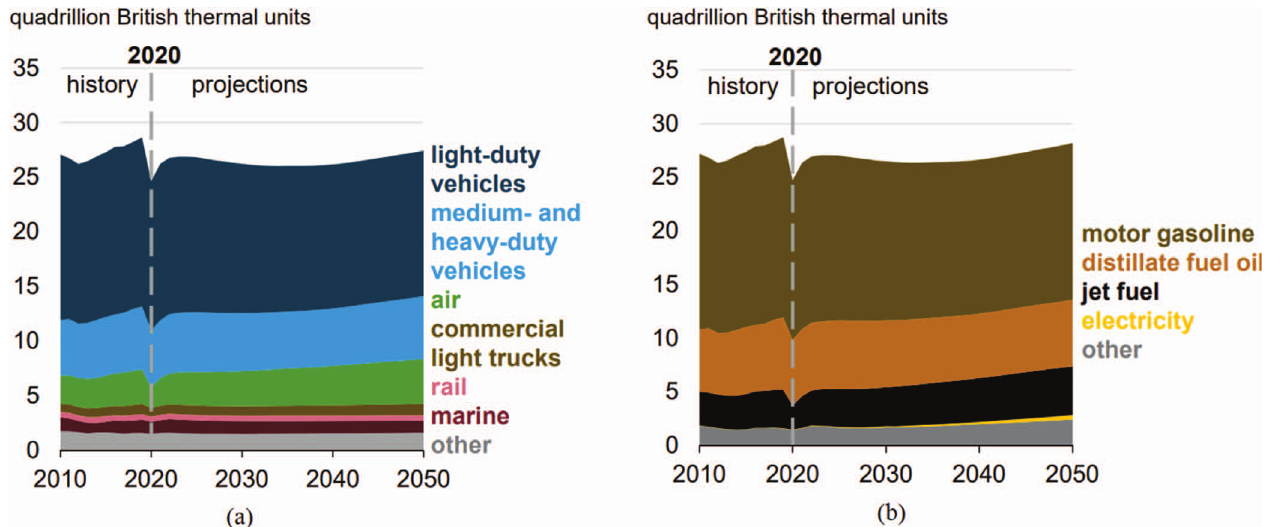
Fig. 1. History and projections of the United States transportation sector energy consumption: (a) by transportation mode and (b) by fuel source